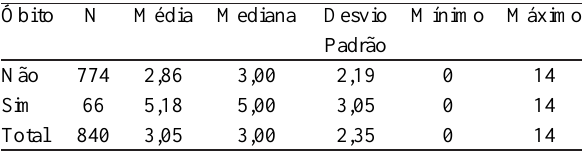
Tabela 5. Comparação da média do EuroSCORE aditivo entre sobreviventes e não sobreviventes.